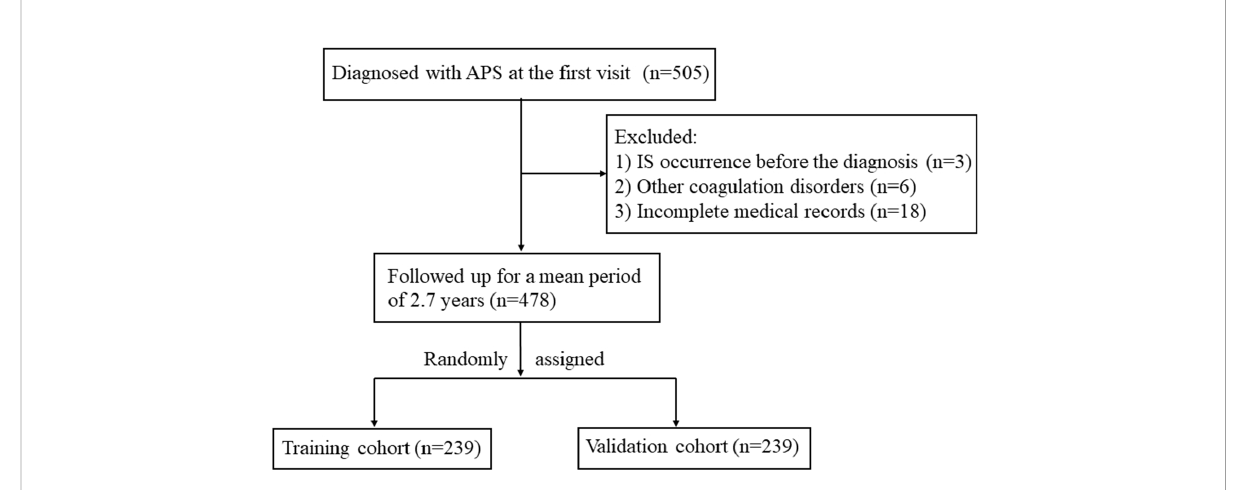
FIGURE 1 Study fl ow diagram. IS, ischemic stroke; APS, antiphospholipid antibody